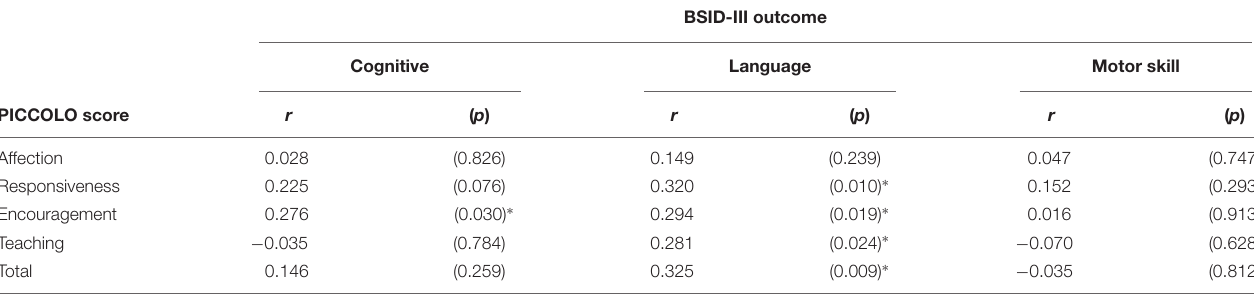
TABLE 4 | Pearson’s correlations between PICCOLO scores and children’s BSID-III scores ( N = 64).